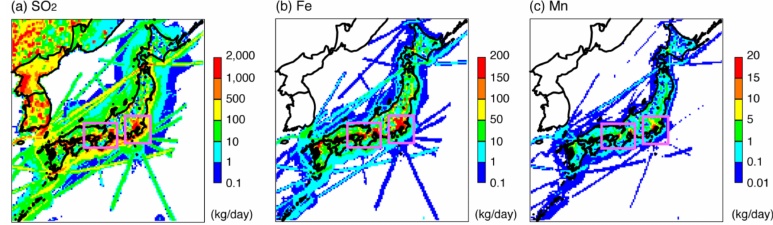
Figure 1. Mapping of the lowermost-layer emissions of ( a ) SO 2 , ( b ) Fe, and ( c ) Mn. Rectangles indicate the Kansai region ( left ) and Kanto region ( right